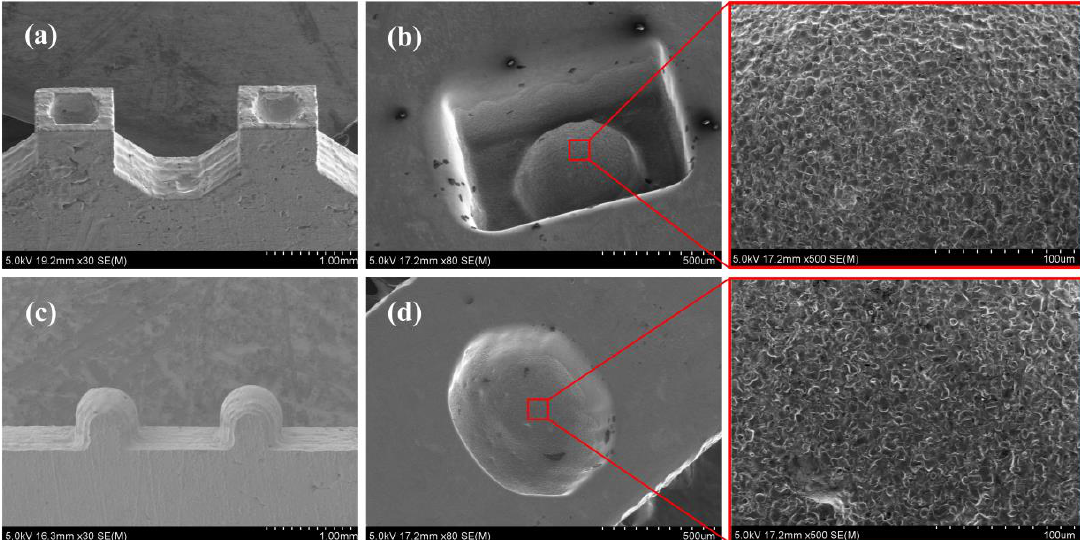
Figure 9. ( a , c ) Composite 3D microelectrodes; ( b , d ) 3D microstructures machined by EDM.